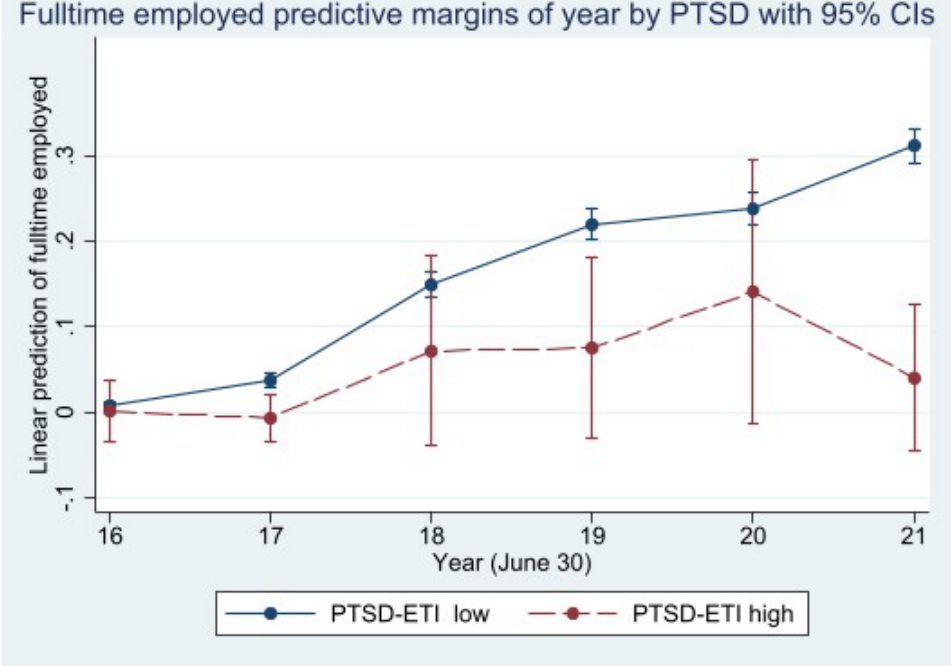
Figure 3. Linear prediction of full-time employment by PTSD-ETI screening diagnosis—2016-2021. Source: IAB-WELLCOME study wave 1; IEB, V16.01